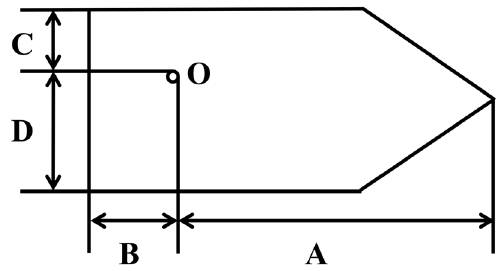
Figure 3. The overall dimension of a ship.